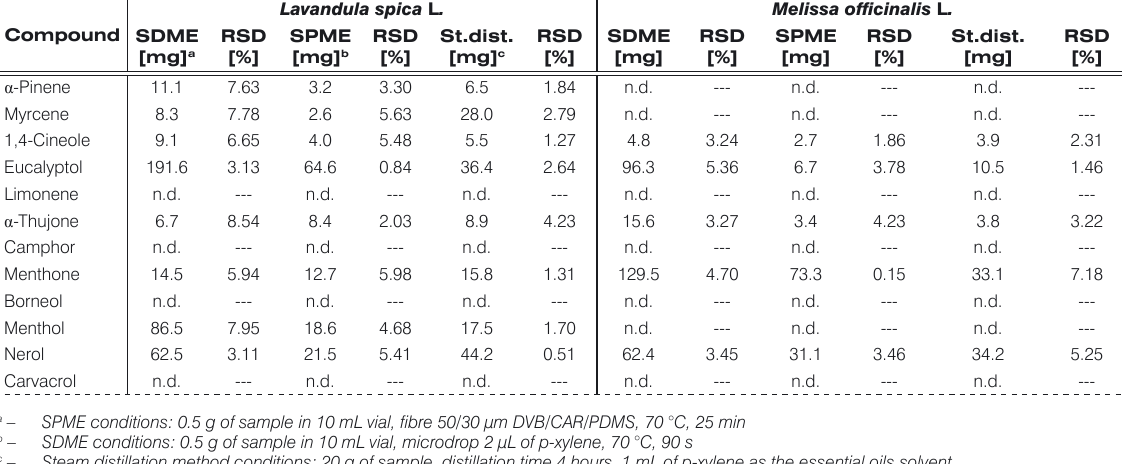
Table 2. Essential oils contents (per 100 g of dried leaves) of Lavandula spica L. and Melissa officinalis L. obtained by various methods Lavandula spica L Compound